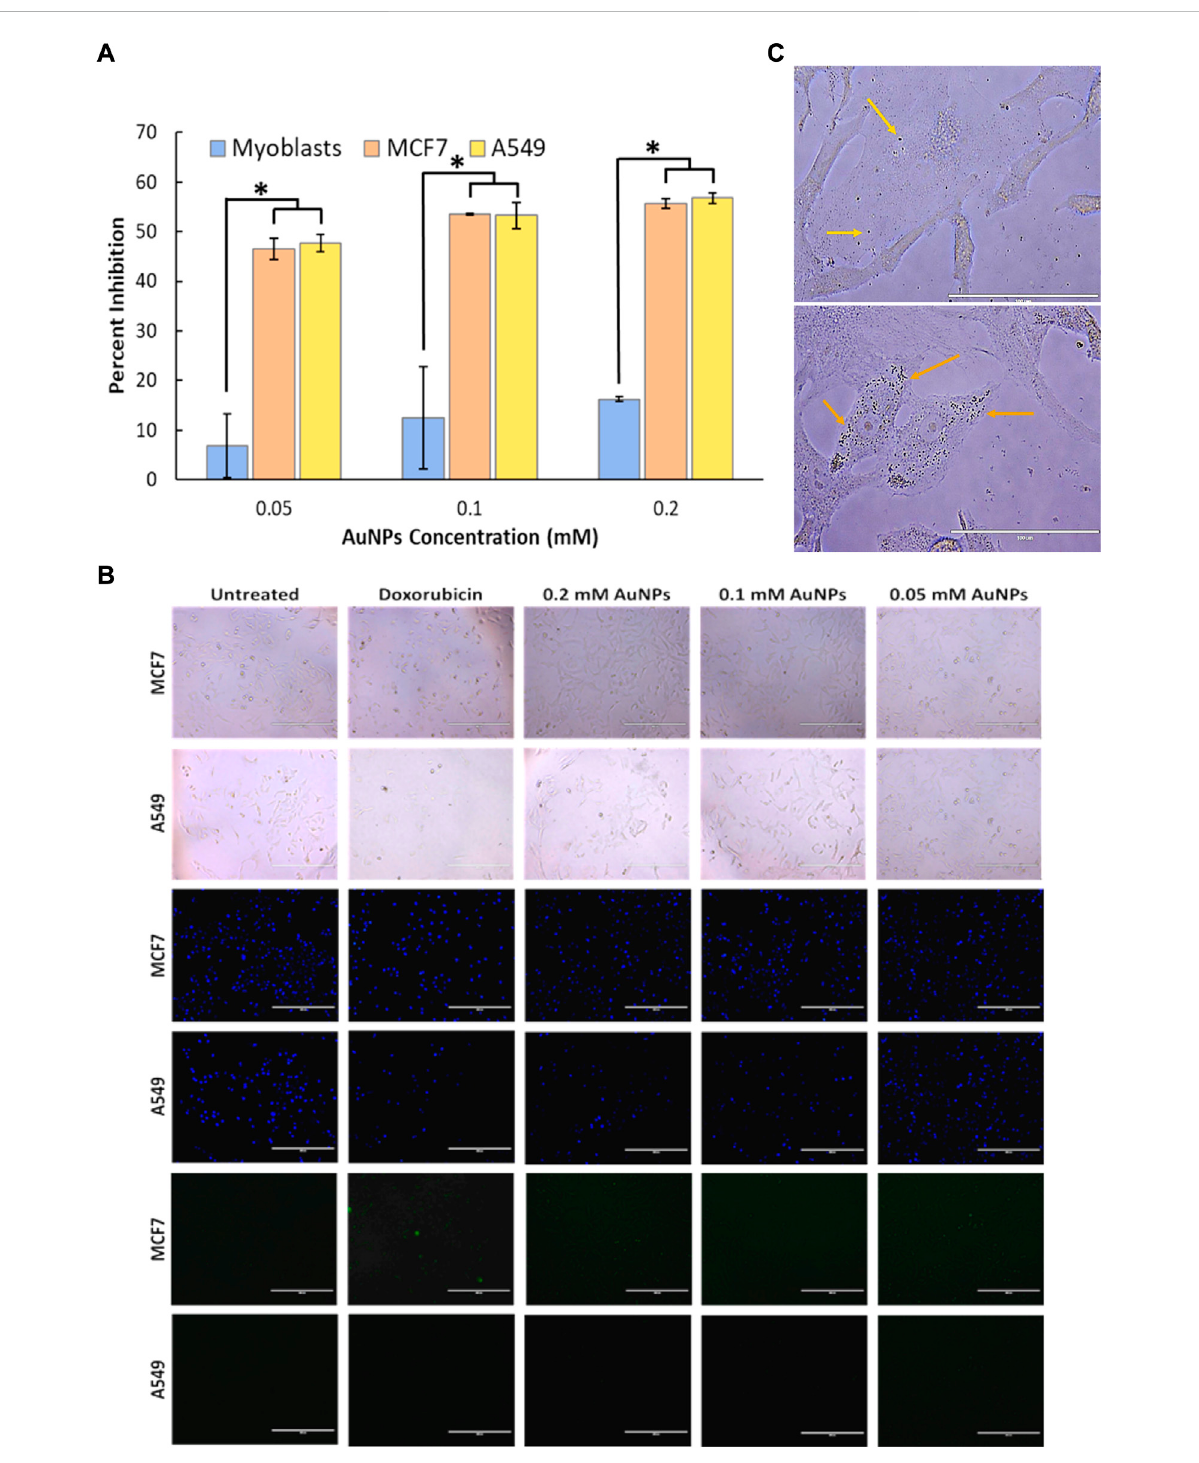
FIGURE 2 In vitro cytotoxicity analysis of (A) biosynthesized gold nanoparticles (0.05-, 0.1-, and 0.2-mM gold nanoparticle concentration) on normal cell lines (myoblasts) and cancer cell lines (MCF7 and A549). A signi fi cant difference between the treatment of cancer cell lines and normal cell lines was observed with a p -value less than 0.05, while no signi fi cant difference was observed within the treatment of cancer cell lines ( p > 0.05). Cellular characterization on the effect of gold nanoparticles with 0.05-, 0.1-, and 0.2-mM concentrations in human breast cancer cells (MCF7) and human lung cancer cells (A549) through its (B) cellular uptake and localization on the cytosolic environment viewed under ×400 magni fi cation, and its effect on (C) cell membrane morphology (bright fi eld), DNA fragmentation (Hoechst 33324 dye), and apoptotic activity (Caspase